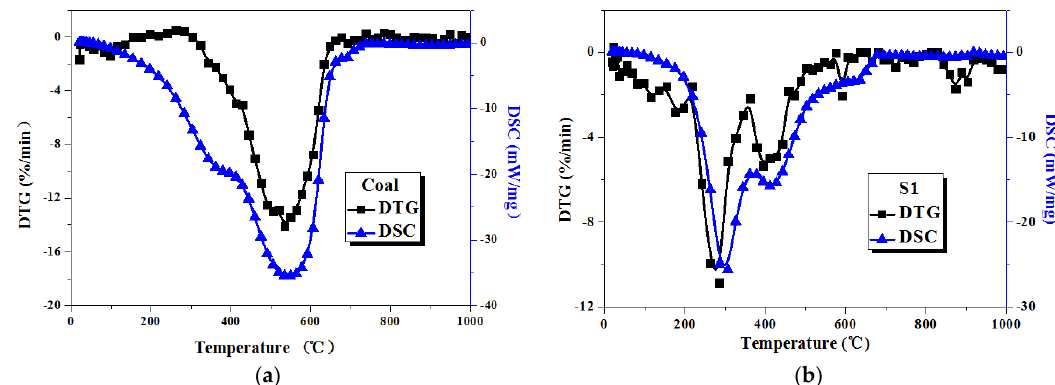
Figure 6. Differential scanning calorimetry (DSC) and DTG curves for coal and S1 sludge sample (heating rate = 30 °C/min) (( a ) coal; ( b ) S 1 ).